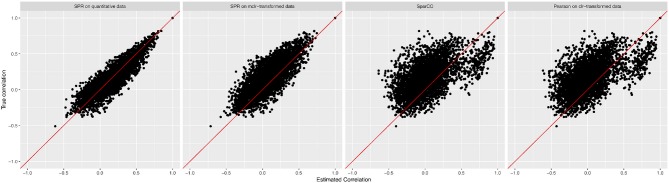
True pairwise correlation values σjk (y-axis) vs. estimated values σ^jk (x-axis) for four methods (from left to right): SPR correlation estimation on quantitative data, SPR correlation estimation on mclrε-transformed compositional data, SparCC estimation (Friedman and Alm, 2012), and Pearson sample correlation on clr-transformed data [as used in SPIEC-EASI (Kurtz et al., 2015)].